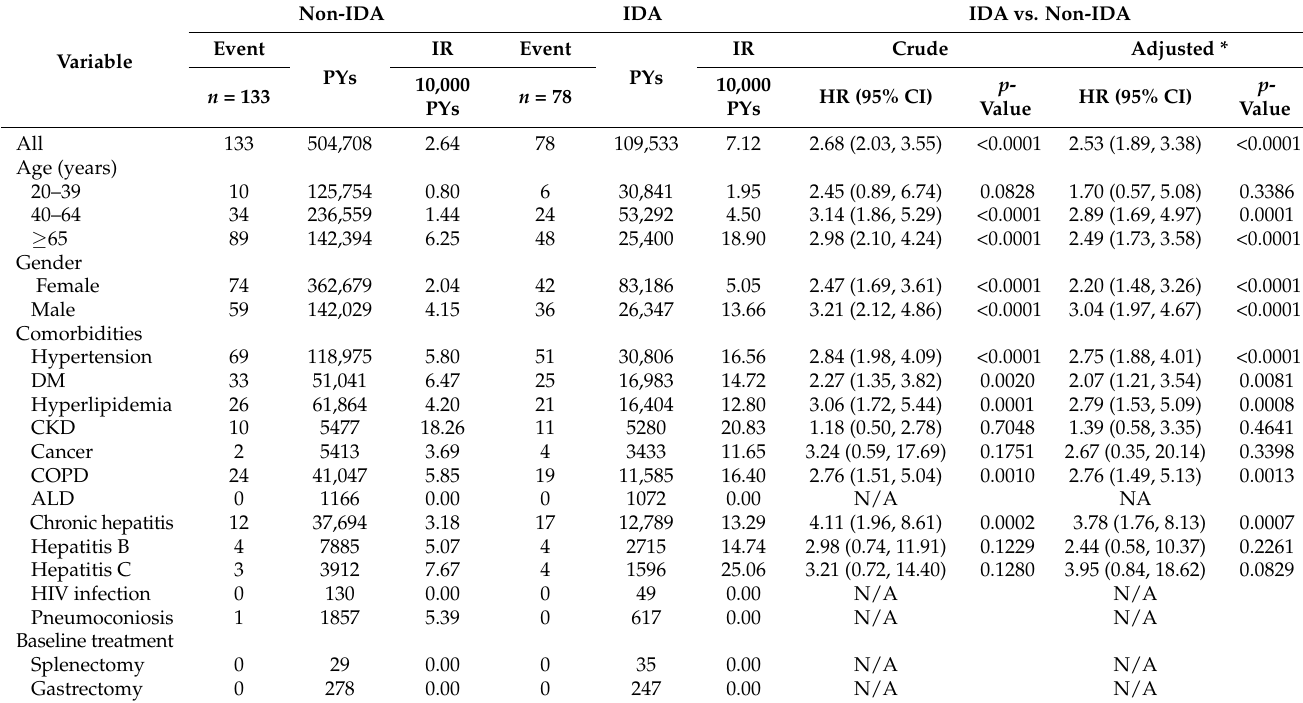
Table 3. Effects of iron-deficiency anemia (IDA) on septic arthritis (SA) stratified by age, gender, comorbidities, and treatment in